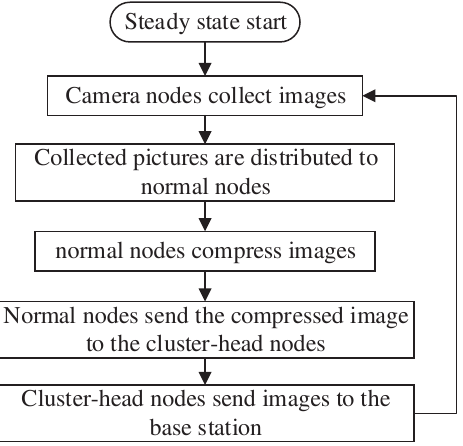
Figure 5. The flowchart of the steady state